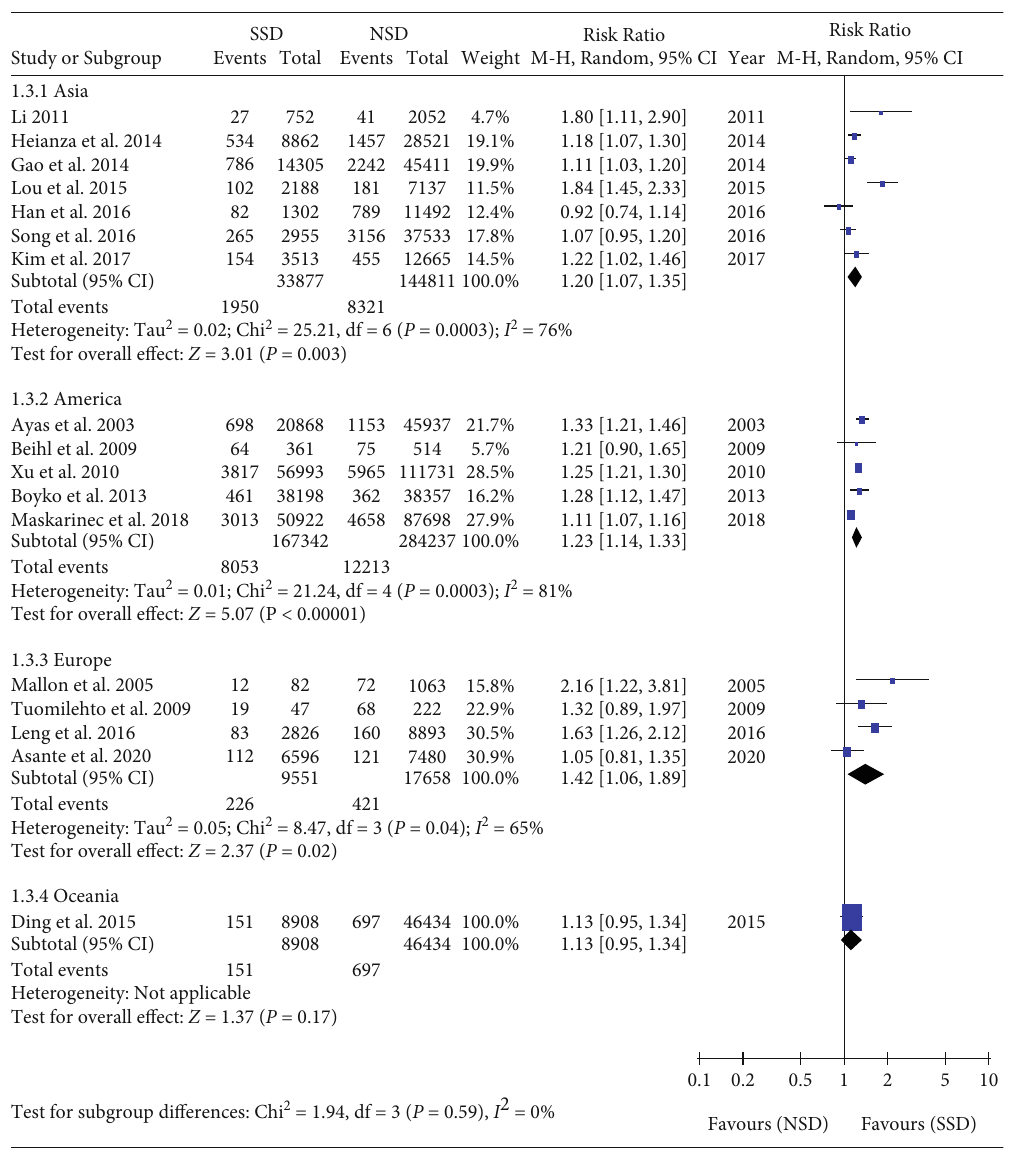
Figure 4: Regional subgroup analysis of the association between SSD and